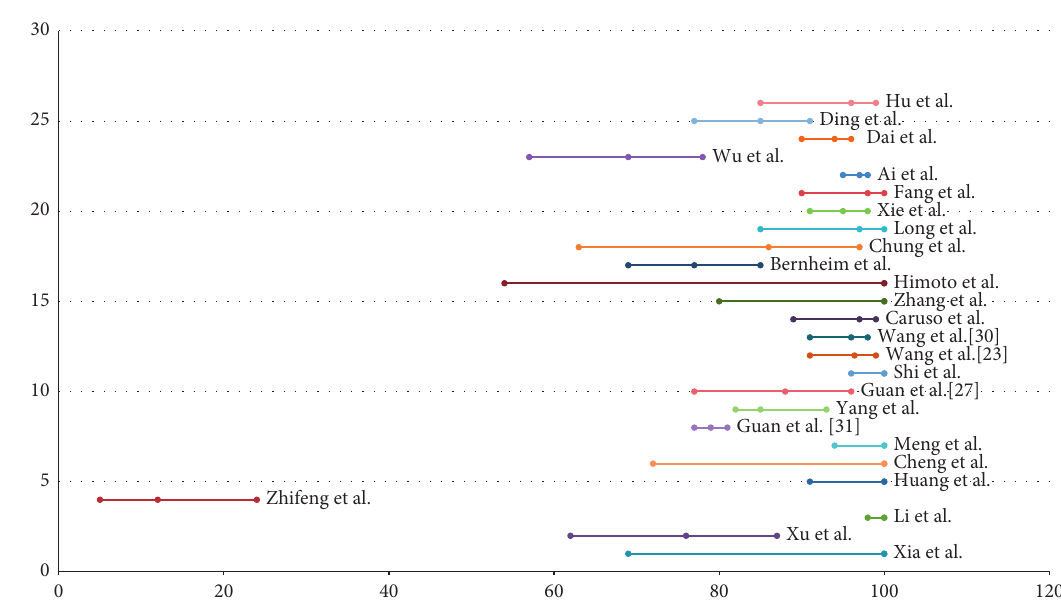
Figure 2: Forest plot showing chest CT sensitivity (95% CI) for all included